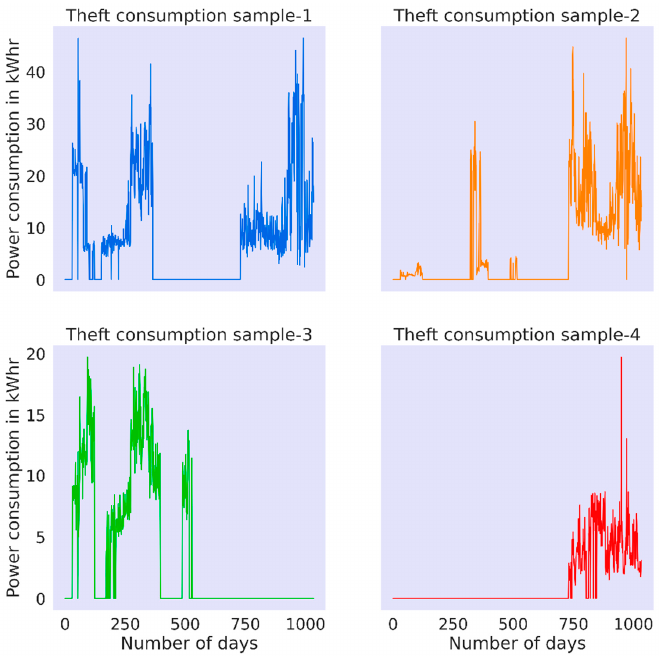
Figure 3. Fraudster consumers: electric consumption pattern in the acquired dataset. Sensors 2021 , 21 , x FOR PEER REVIEW